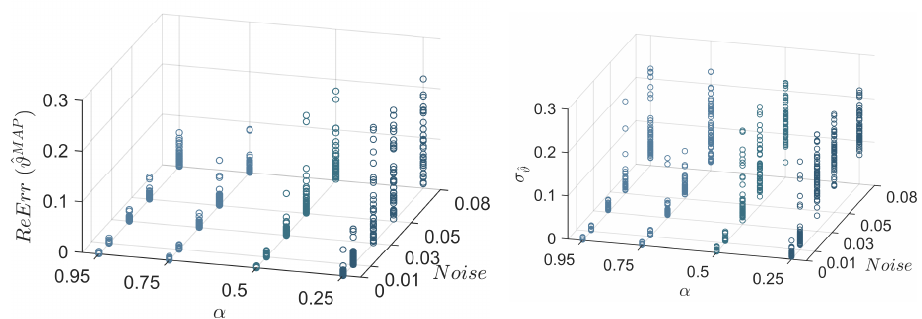
Figure 7. Reconstructed error (ReErr) of the identified damage location ˆ ϑ using the frequency-based algorithm: the maximum a posteriori (MAP) values ˆ ϑ MAP ( left ); and the standard deviation σ ˆ